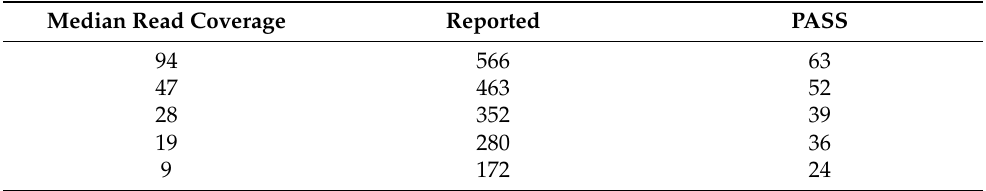
Table 3. Number of TE insertion events reported by TEfinder in Y2 population with reduced cov- erages.